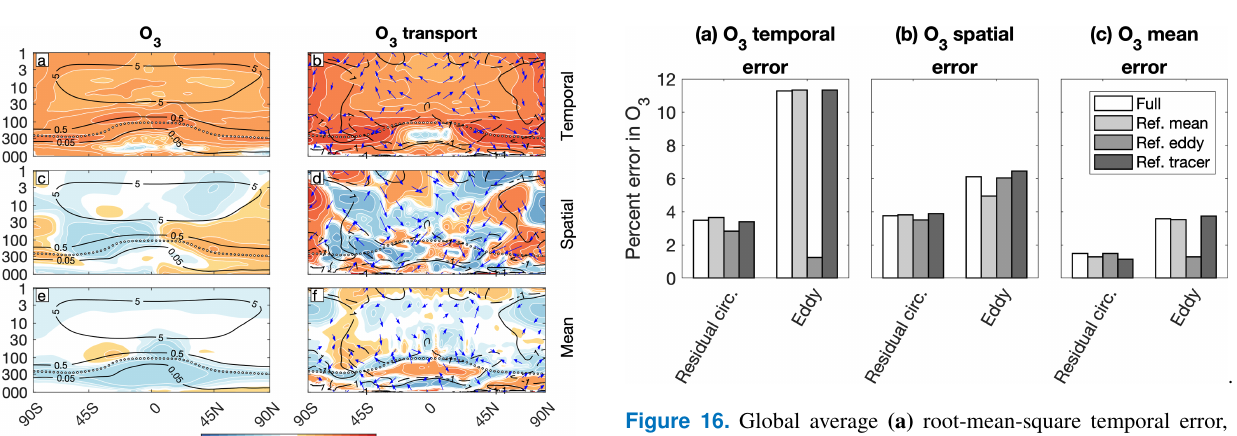
Figure 16. Global average (a) root-mean-square temporal error, (b) root-mean-square spatial error, and (c) sign-adaptive mean error in ozone attributable to the TEM residual circulation and TEM eddy flux convergences, based on the projections in the right column of Fig. 14